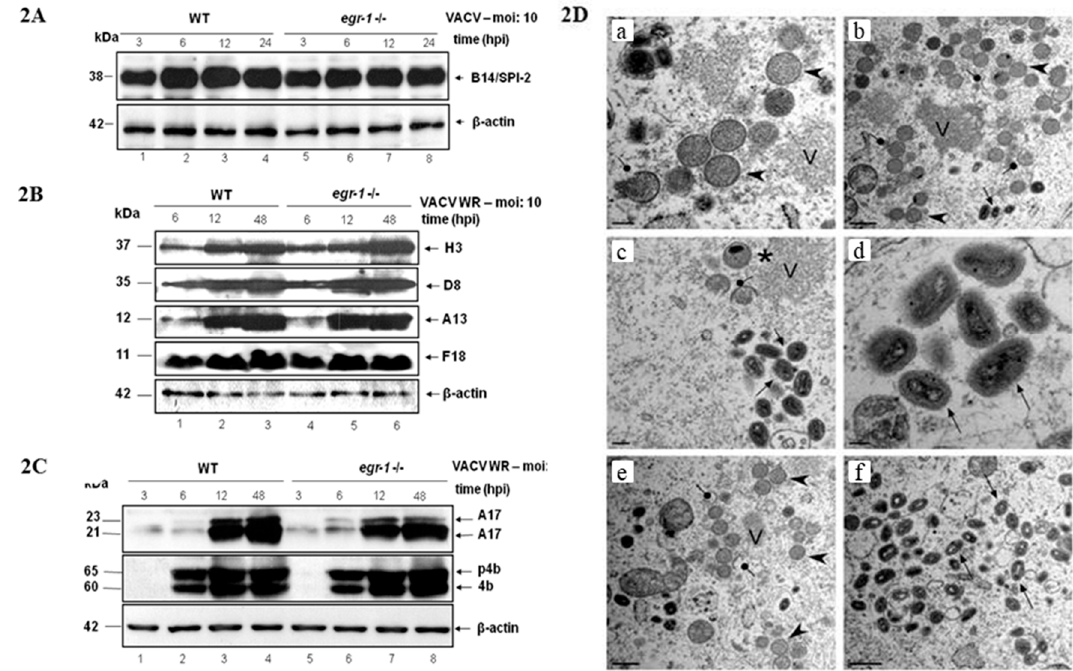
Figure 2. Egr-1 gene deletion does not affect VACV gene expression, protein processing or viral morphogenesis. ( A – C ) Egr-1 gene deletion does not affect VACV gene expression or protein processing—Western blotting analysis of VACV infected WT and egr-1 − / − starved MEFs (FBS 0.1%) at an MOI of 10 for the indicated times and with the following antibodies: (( 2A )—Early viral gene expression) anti-B14 antibody; (( 2B )—Late viral gene expression) anti-H3, A13, F18 and D8 antibodies; (( 2C )—Viral protein processing) anti-A17 and -p4b/4b antibodies. The molecular masses are indicated (KDa) on the left. ( D ) Egr-1 gene deletion does not affect VACV morphogenesis—Confluent monolayers of WT and egr − / − MEFs were serum-starved for 12 h and infected with VACV for 18 h at an MOI of 2. Cells were then fixed in situ and processed for transmission electron microscopy. WT (panels e,f) and egr − / − MEFs (panels a–d) contained all the normal intermediates in virion morphogenesis. Simbols—arrowheads: Immature virions; V: Virosomes; lollipops: Crescents; arrows: Mature virions; asterisk: Immature virions with nucleoids; Mature virions with proper brick-shaped morphology and biconcave core: arrows (panel d). Scale bar: a,c—200 nm. b,e,f—400 nm. d—100 nm. Data are representative of three independent experiments with similar results.